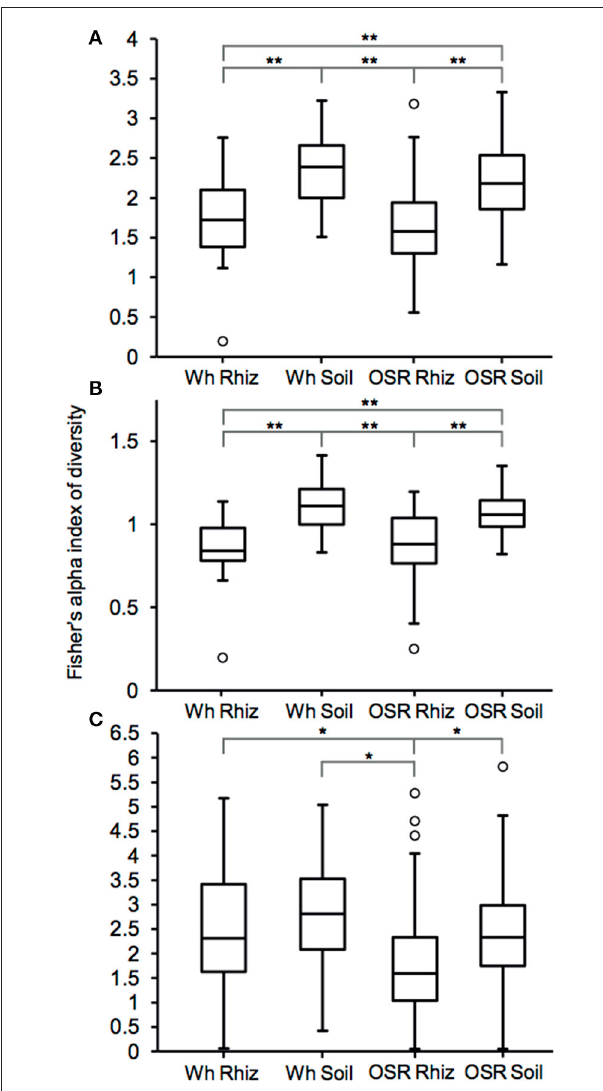
FIGURE 3 | Box plot comparisons of plasmodiophorid diversity between habitats for (A) all, (B) core, and (C) satellite OTUs using Fisher’s alpha index of diversity. Boxes represent the interquartile range (IQR) between the first and third quartiles and the line inside represents the median. Whiskers denote the lowest and highest values within 1.5 × IQR from the first and third quartiles, respectively. Circles represent outliers beyond the whiskers. Asterisks denote significant differences in comparisons of diversity at the P < 0.05 level determined by two-sample t -tests * P < 0.05 and ** P < 0.005).